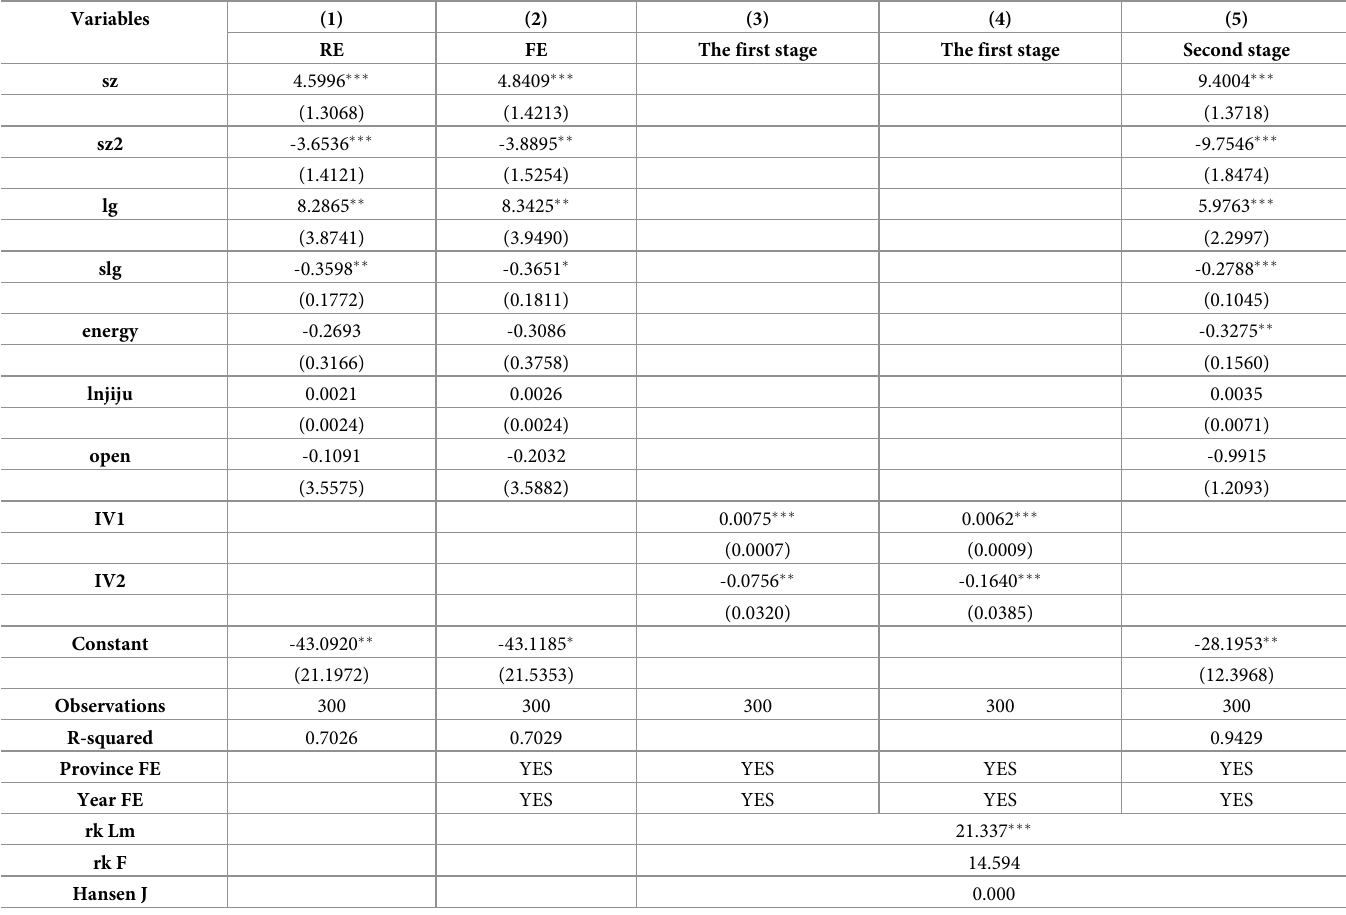
Table 4. Impact of digital economy development on rural carbon